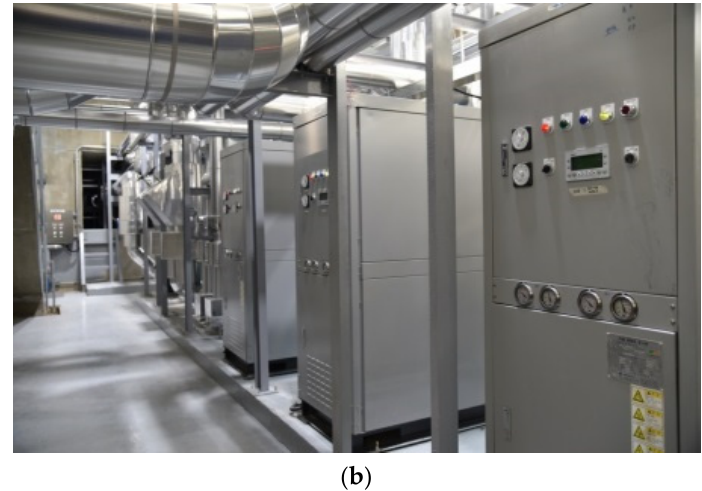
Figure 3. Details of ground source and sewage water source components: ( a ) location and configuration of the system; ( b ) picture of heat pumps.